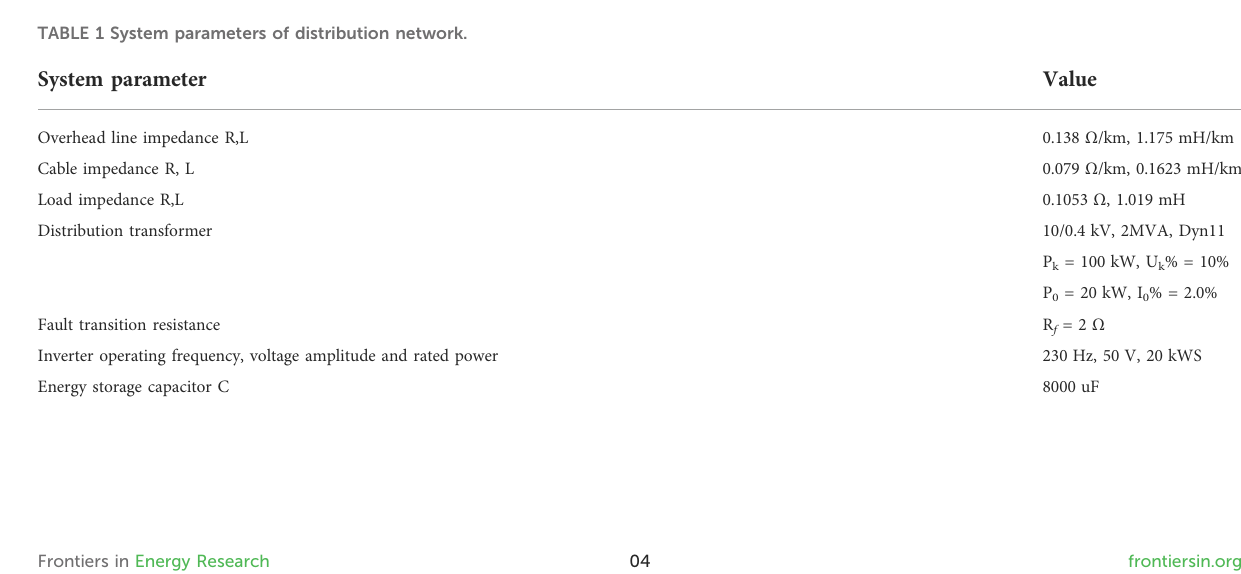
TABLE 1 System parameters of distribution network.